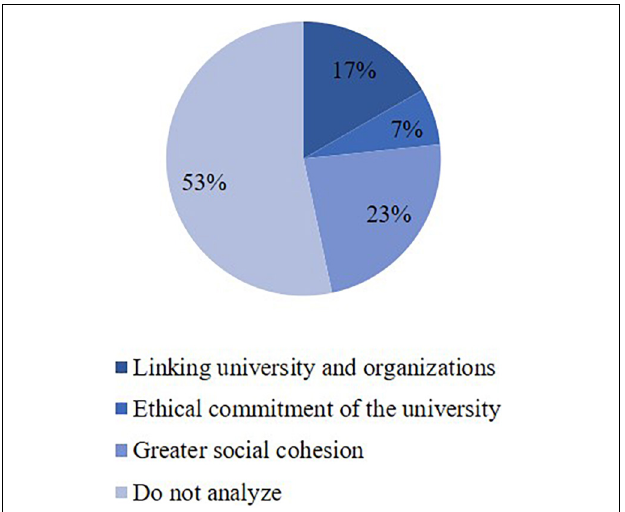
FIGURE 4 | Frequency of coded segments in each category: universities,’ organizations’, and